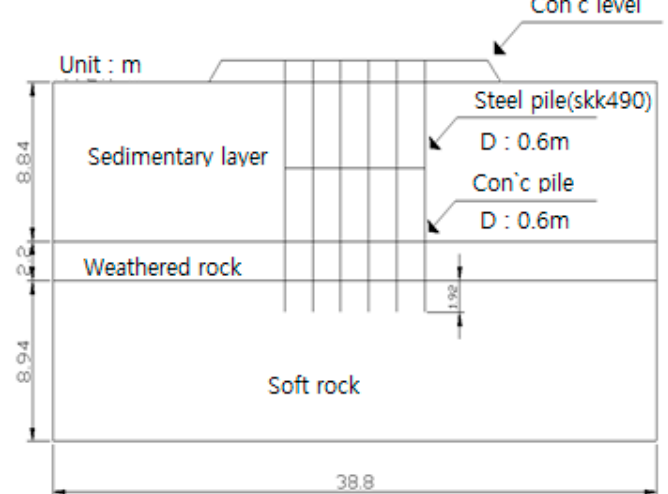
Figure 8. Analysis section.